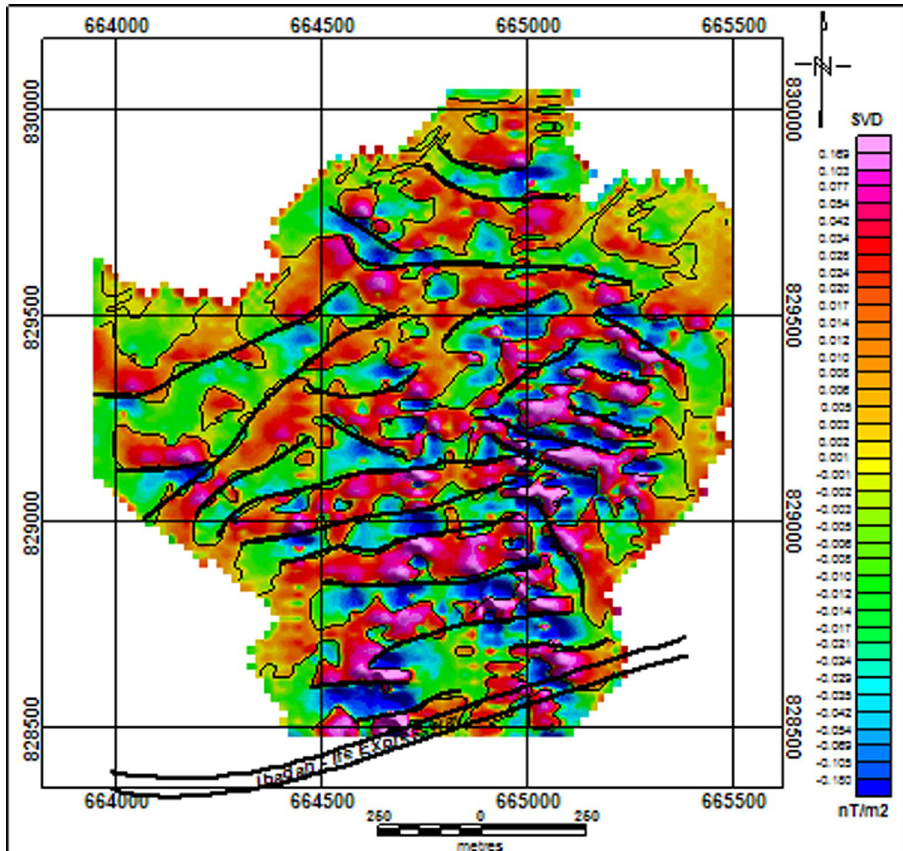
Fig. 7 Second vertical deriva- tive (SVD) map of the study area showing identified linea- ments with black